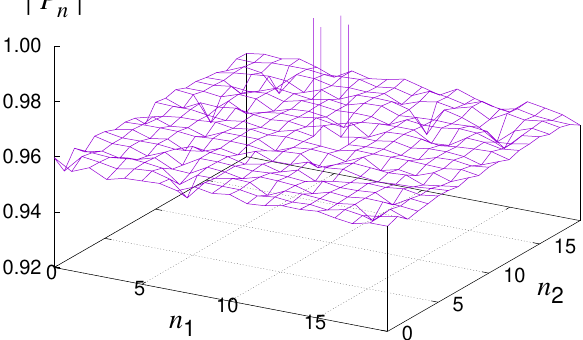
Figure 11 . The absolute value of the plaquette P n is plotted against n = ( n 1 ; n 2 ) for the punctured model with the log de(cid:12)nition (2.11) of the topological charge for ( (cid:12); L ) = (12 ; 20) with (cid:18) = (cid:25) . The removed plaquette corresponds to n = K = (10 ; 10) in this (cid:12)gure. (cid:12) = 12 in agreement with the value observed in (cid:12)gure 11. If we (cid:13)ip the sign of (cid:18) , which corresponds to the parity transformation, we (cid:12)nd that